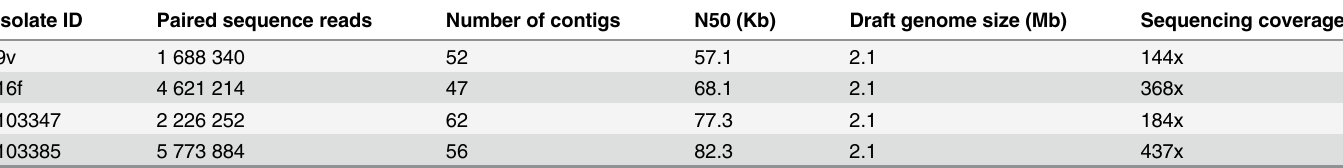
Table 4. NGS data and assembly metrics.